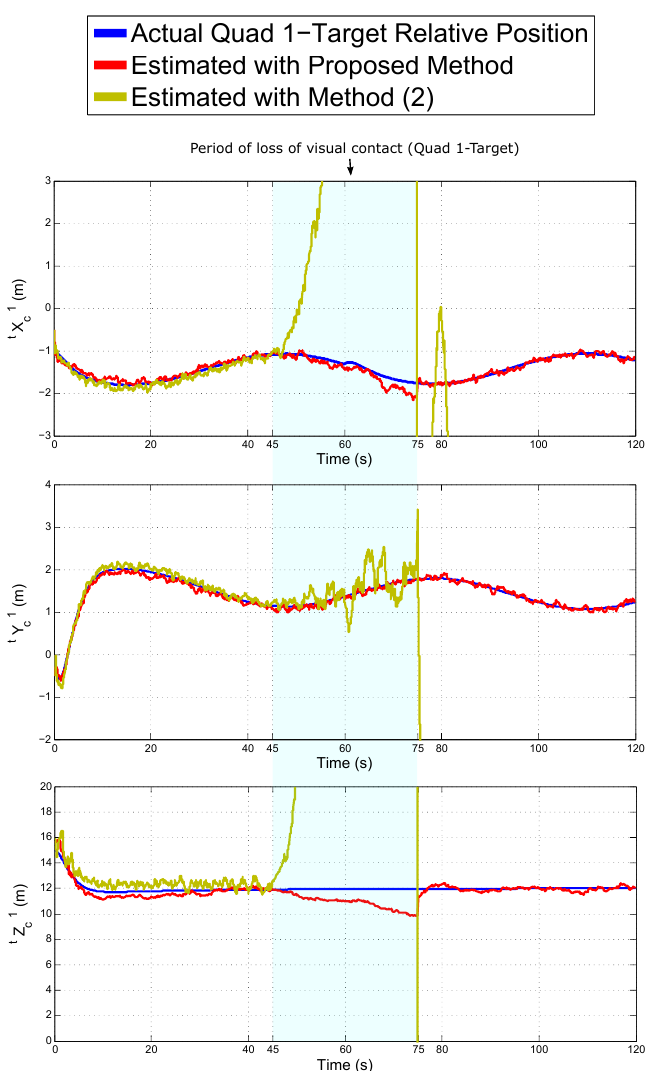
Figure 10. Estimated relative position of Quad 1 with respect to the target with a period of loss of visual contact of the target by Quad